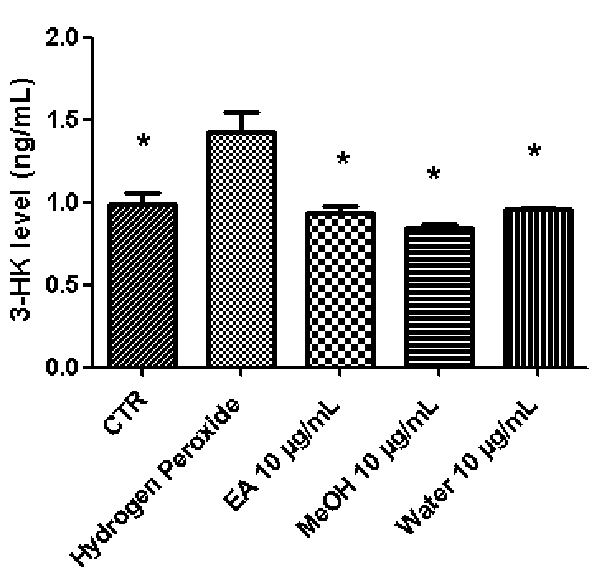
Figure 5. Inhibitory e ff ects induced by P. africanum water, methanol (MeOH), and ethylacetate (EA) extracts (10 µ g / mL) on extracellular levels (ng / mL) of 3-hydroxykynurenine (3-HK). 3-HK was measured in the medium of hypothalamic HypoE22 cells stimulated with extracts and challenged with hydrogen peroxide (1 mM). ANOVA, p < 0.05; post hoc test, * p < 0.05 vs. Hydrogen Peroxide group.